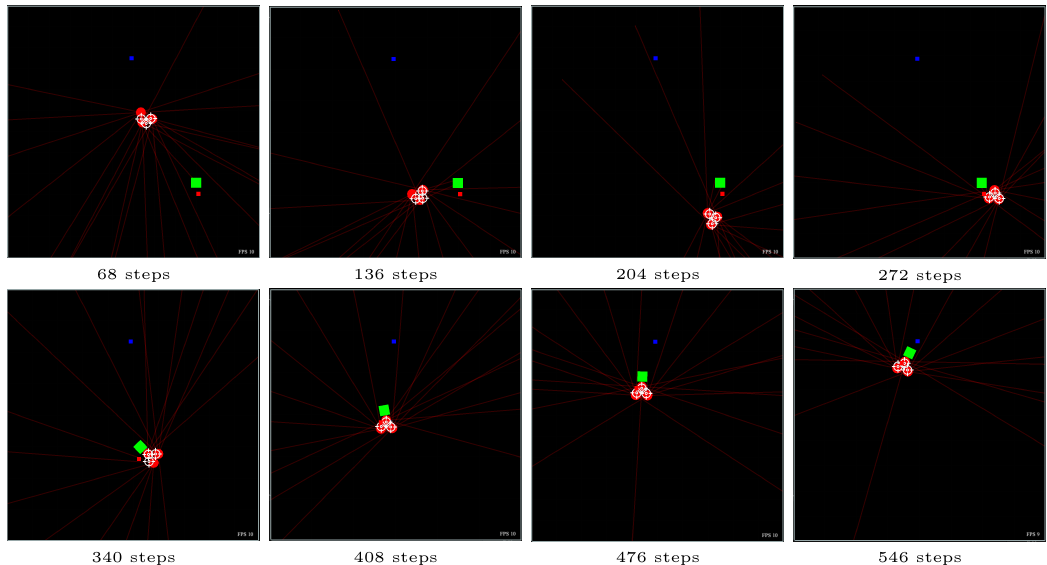
Figure 7. Environment of 500 × 500 cm with three robots (red circles) and one box (green) that needed to be located and transported to the home zone (blue). The figure presents several steps of our simulator with the learned policy. Each simulation step was equal to 2/3 seconds, so this simulation lasted 6 minutes. It is shown how the swarm was able to move towards the box and push it to the goal within 546 simulation